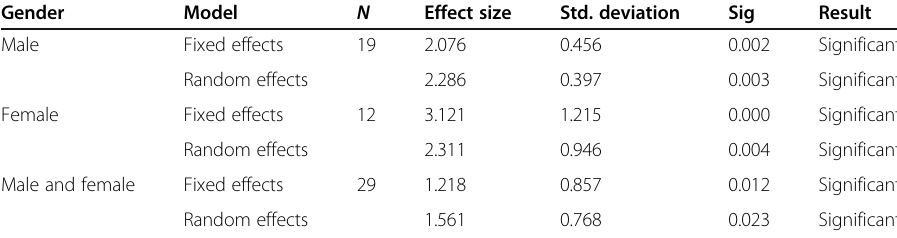
Table 12 Effect size by gender Gender